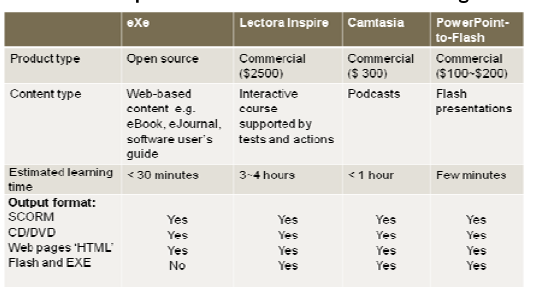
Table 3: Comparison between content authoring tools - II